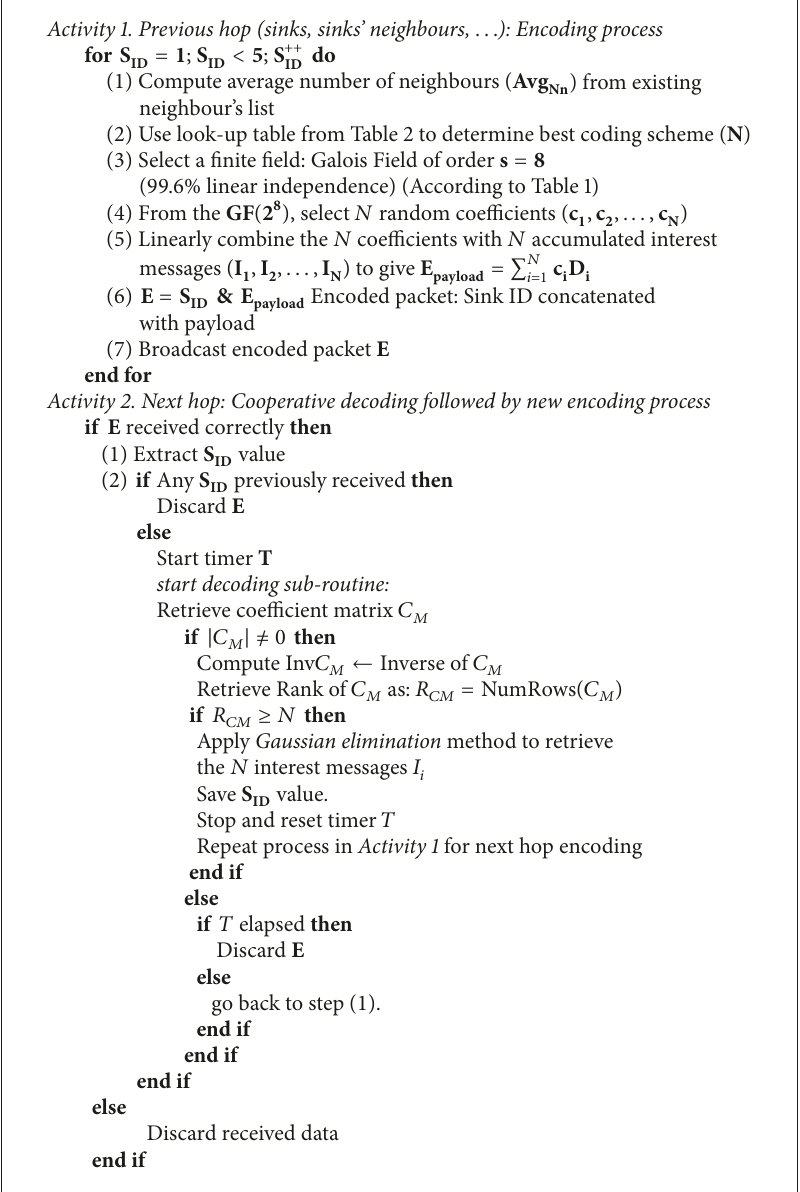
Algorithm 1: The CoAdNC-GBR